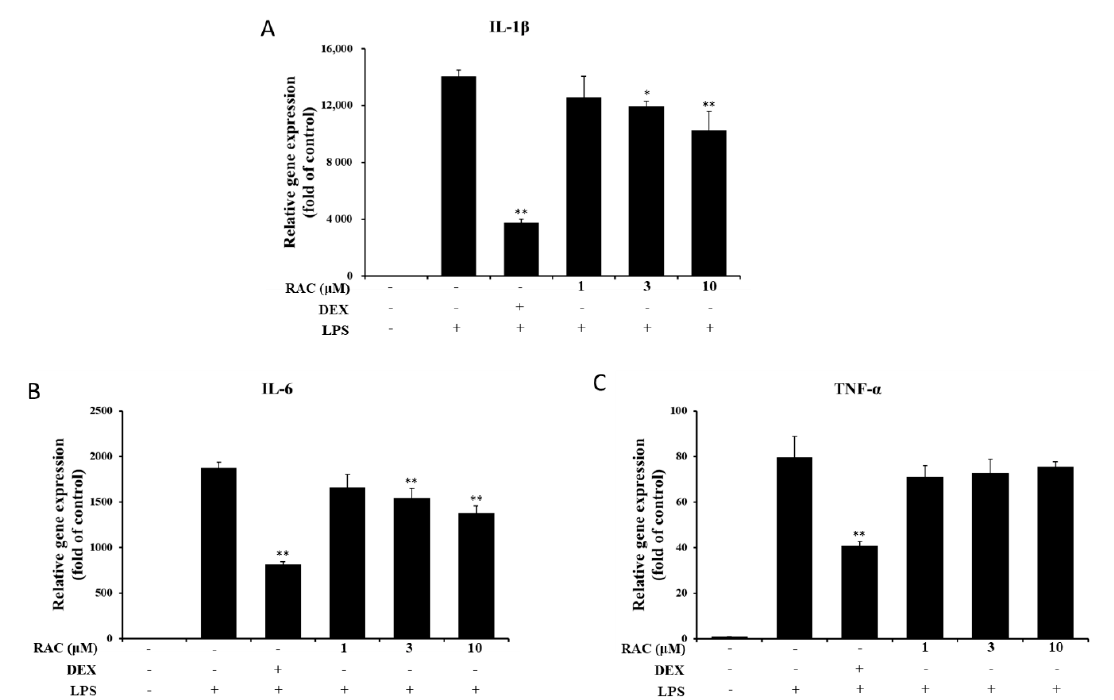
Figure 2. Effect of RAC on LPS-induced proinflammatory gene expression. J774A.1 cells were treated with 200 ng / mL LPS after pretreatment with 10 µ M dexamethasone or 1, 3 or 10 µ M RAC for 1 h. ( A ) IL-1 β , ( B ) IL-6 and ( C ) TNF- α gene expression was determined by quantitative real-time PCR. The data were normalized to 18S rRNA expression and are presented as the fold change compared to the untreated group. The results are presented as the mean ± SD of three individual experiments. * p < 0.05, ** p < 0.01 compared with the LPS only-treated group. DEX, 10 µ M dexamethasone.